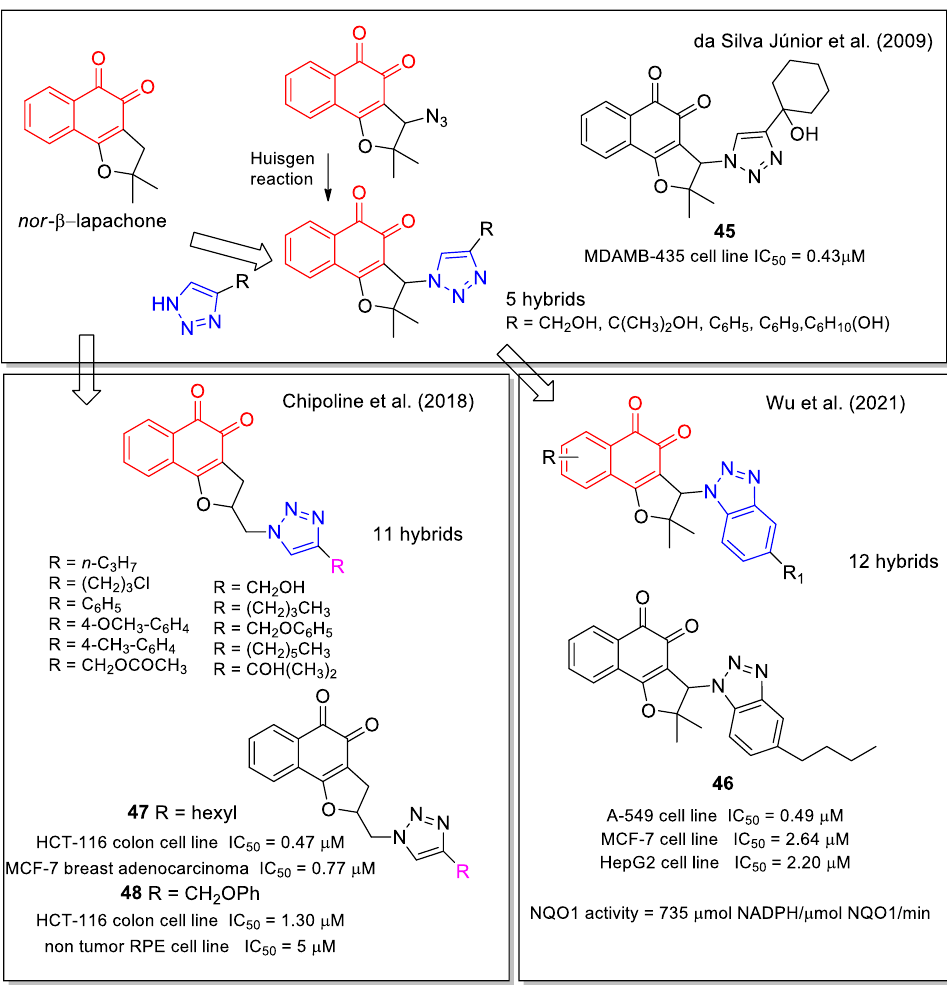
Figure 19. 1,2-Naphthoquinone-substituted 1,2,3-triazole hybrids as reported by da Silva Júnior,